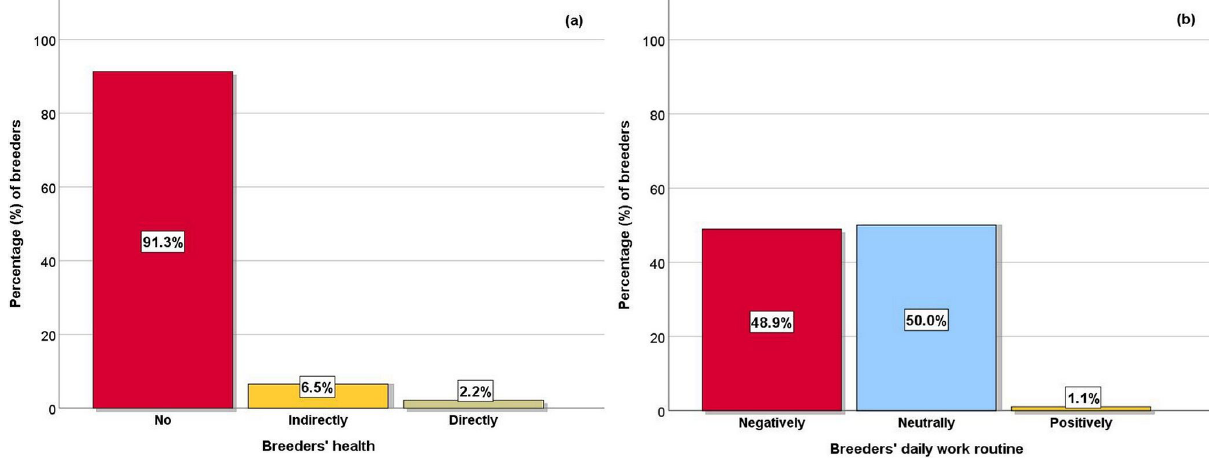
Figure 1. (a) Effect of the COVID-19 pandemic on breeders’ health and (b) effect of the restrictive measures due to the pandemic on breeders’ daily work routine.